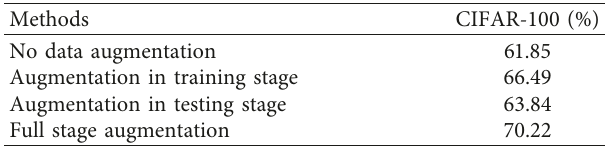
Table 5: Comparison with state-of-the-art algorithms on CIFAR-